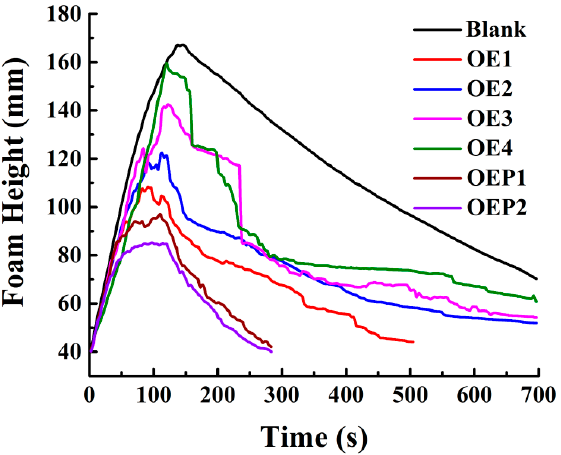
Figure 5. Changes in the foam heights of the samples of polycarboxylate superplasticizer (20 wt%) mixed with various defoamers (0.1 wt%) against time.